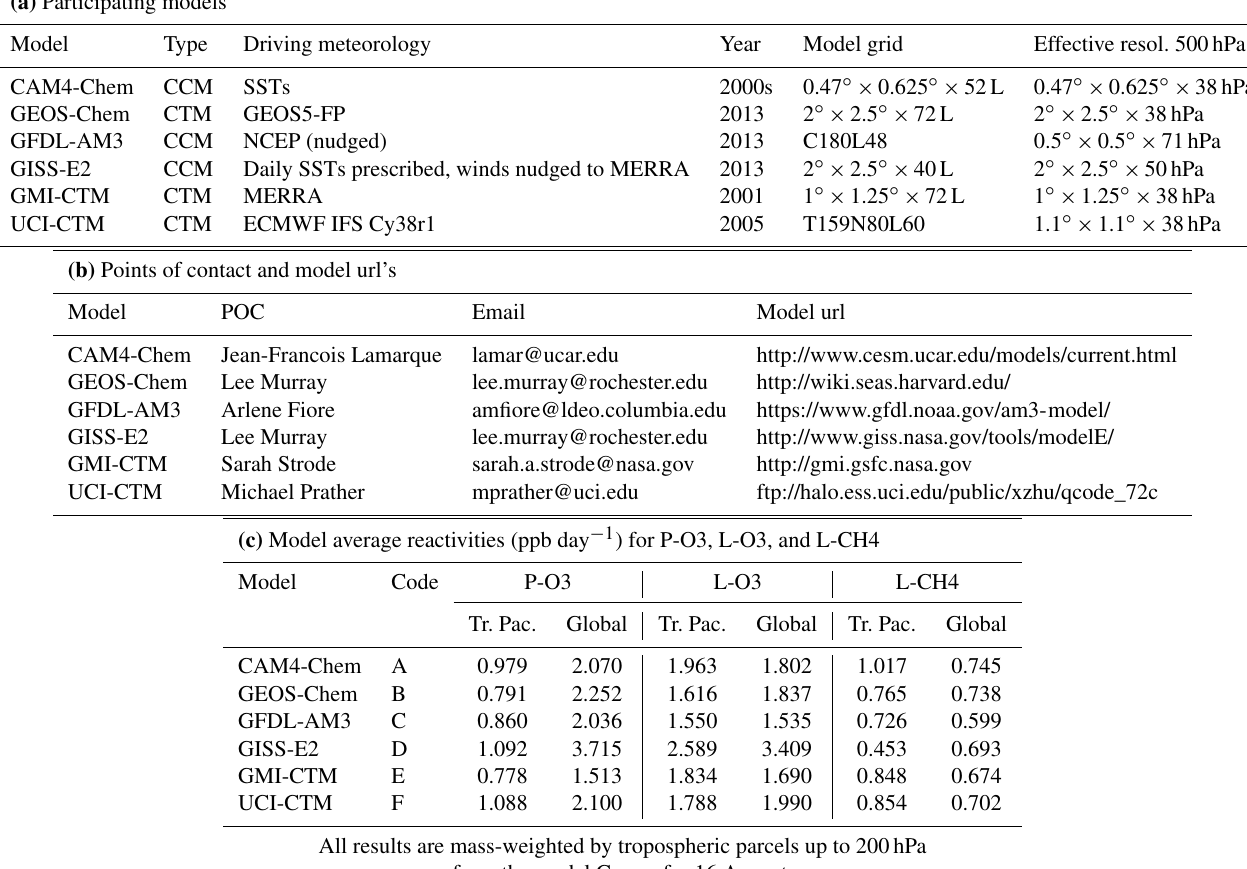
Table 1. Chemistry-Transport and Chemistry-Climate models used in this work. (a) Participating